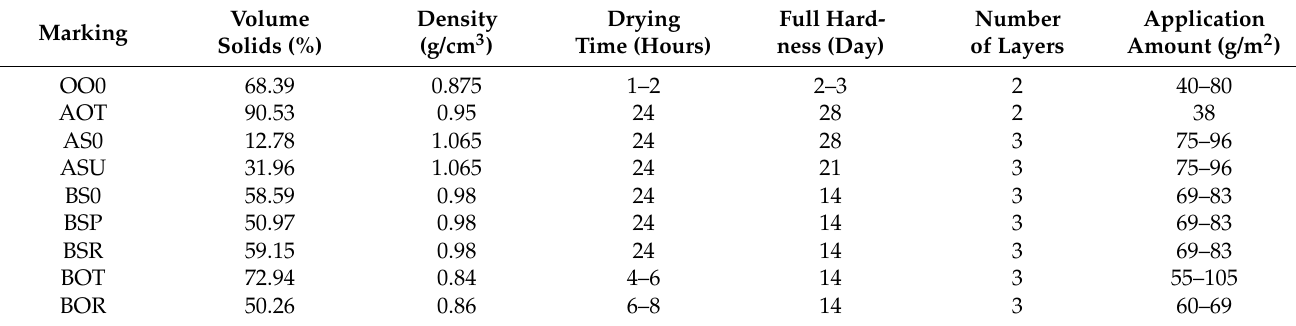
Table 2. Markings and important properties of tested coatings.